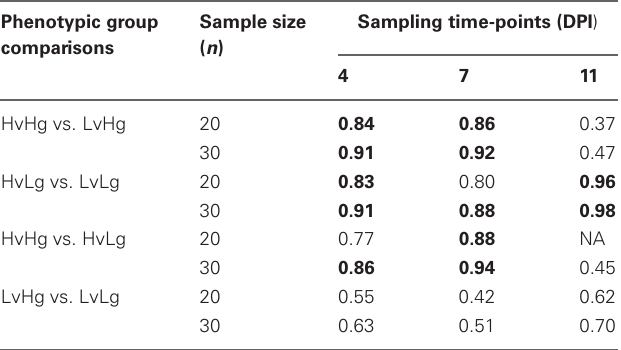
Table 4 | Expected discovery rate (EDR) comparing 20 and 30 biological